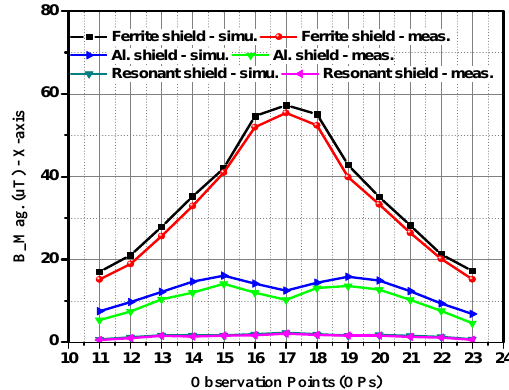
Figure 23. Measurement and simulation B-Mag ( µ T) on the z -axis for the three shielding types.